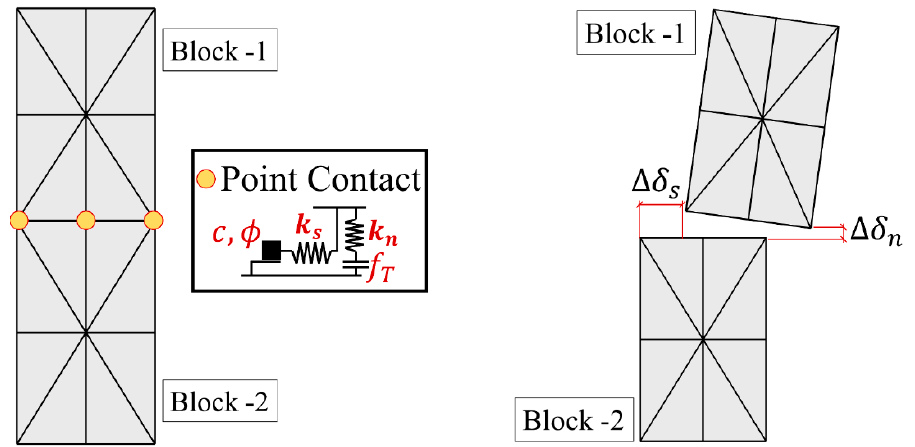
Figure 1. Point-contact representation and defined orthogonal spring (in Figure 1. Point ‐ contact representation and defined orthogonal spring (in 2D).